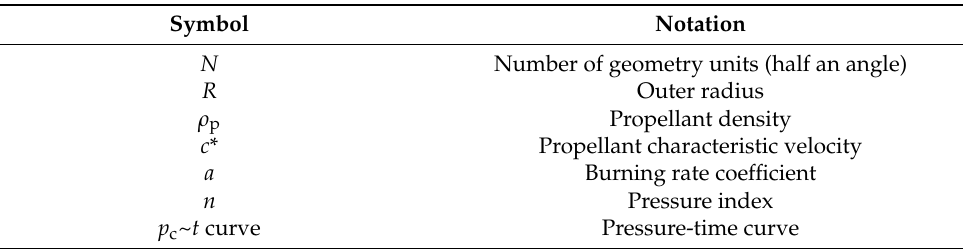
Figure 2. Steps of performance prediction and grain reverse design. Table 1. Given variables for reverse internal ballistic